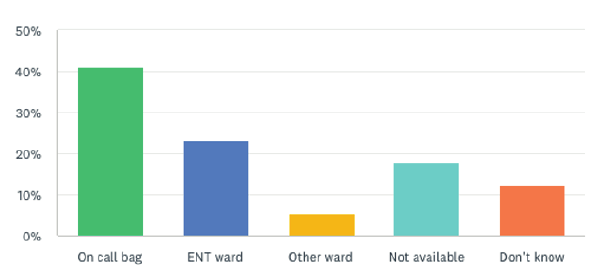
Figure 6. ‘What is the availability of purpose made posterior balloon packs in your trust?’